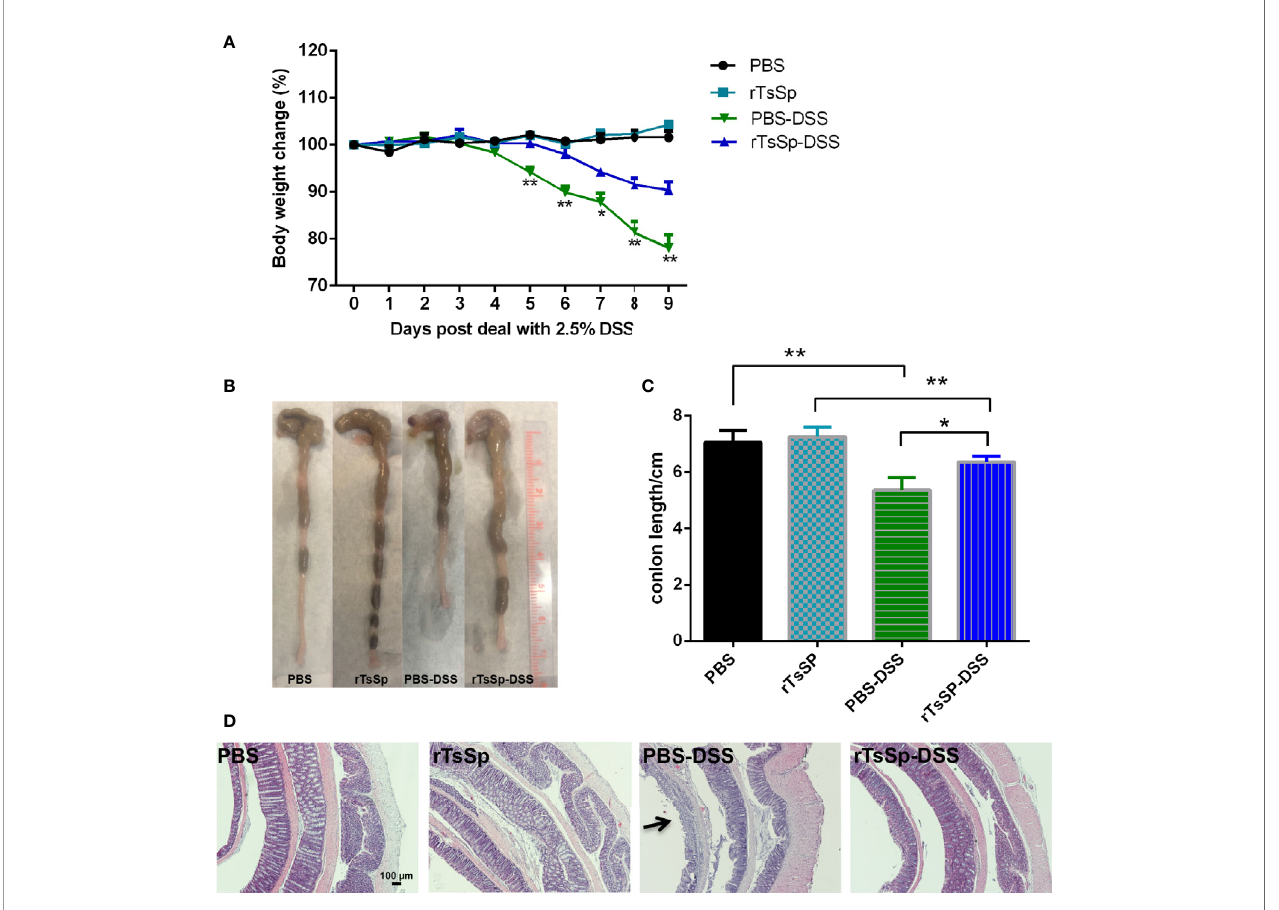
FIGURE 4 | Immunization of the unique Trichinella -derived protein-rTsSp prevents DSS-induced colitis in mice. (A) Weight change in percent, (B) macroscopic characteristics of the colon, (C) colon length and (D) H&E stain of colonic sections were evaluated. The data shown are means ± SEM (5 mice per group) from one of three separate experiments performed showing similar results. * P < 0.05, ** P <